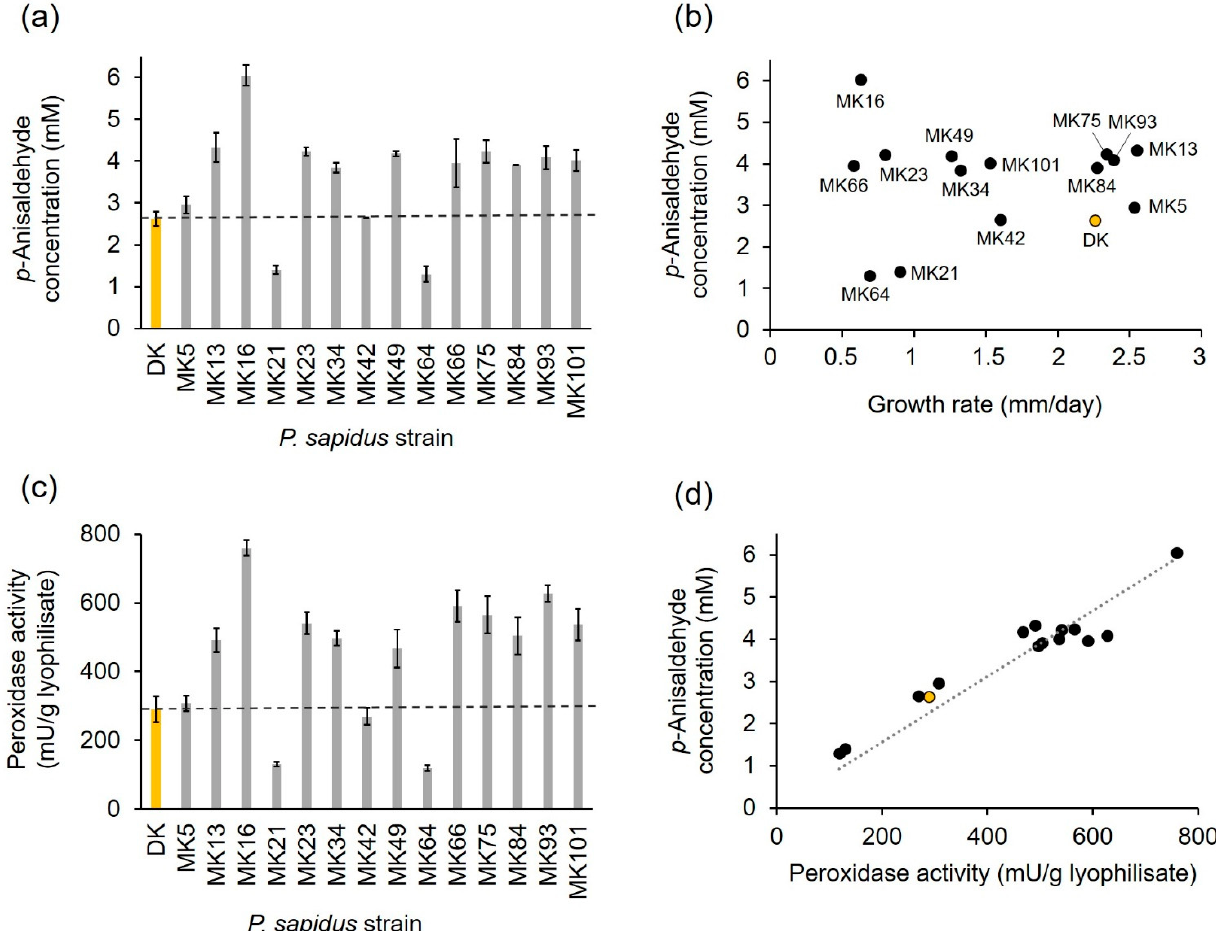
Figure 3. Alkene cleavage activity in comparison to peroxidase activity and growth rate of selected monokaryons and the parental dikaryon (yellow bar or circle) of P. sapidus . ( a ) Enzymatically generated concentration of p -anisaldehyde after conversion of trans -anethole (33.5 mM) using 30 mg/mL finely ground lyophilized P. sapidus mycelium in the presence of 25 mM MnSO 4 , 100 µ M H 2 O 2 , and 50 mM sodium acetate buffer pH 3.5 for 16 h at RT and 200 rpm. ( b ) Comparison of alkene cleavage activity for the lyophilized P. sapidus mycelium after submerged cultivation and radial growth rate for the cultivation on SNL agar plates. ( c ) Peroxidase activity of the lyophilized mycelium. ( d ) Comparison of alkene cleavage and peroxidase activity of the lyophilized mycelium of the P. sapidus strains. p -Anisaldehyde concentrations are the average of duplicate experiments, and peroxidase activities the average of triplicate experiments of two independent biological replicates (with standard deviations shown as error bars in ( a , b )). Growth rates are the average of two independent biological replicates cultivated under the same